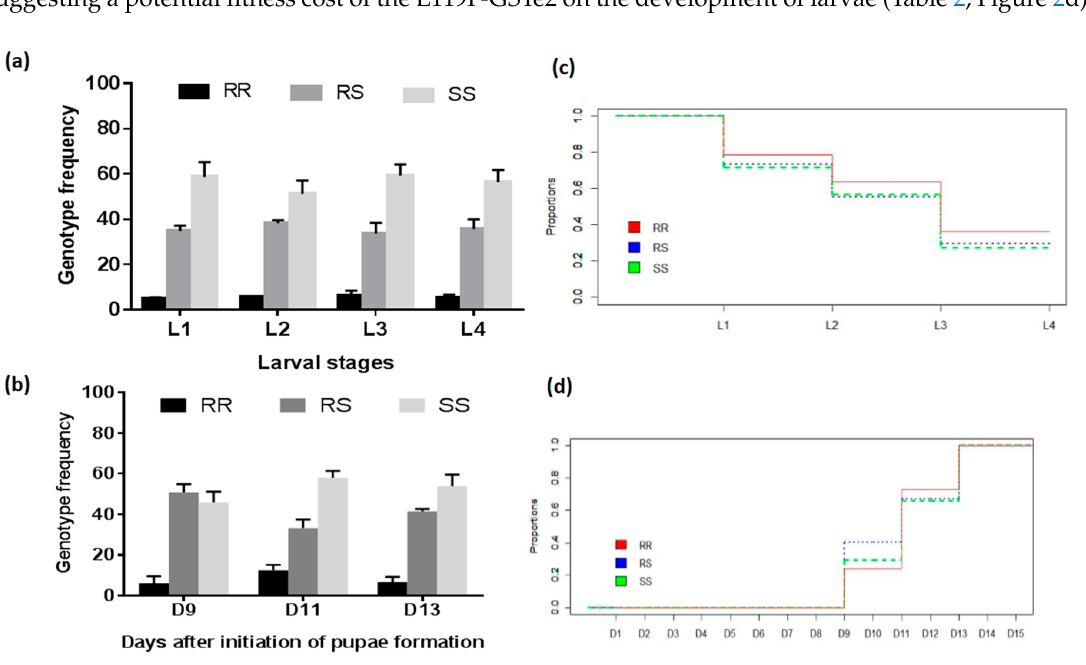
Figure 2. Distribution of the L119F-GSTe2 genotypes at different time-points of the development of immature stages. ( a ) Histogram of the variation in genotypes frequency during the development of larvae (L1, L2, L3, and L4 represent different larval stages) and pupae formation ( b ); ( c ) the proportion of larvae surviving at each developmental stage from hatching (D1) to formation of the pupae; ( d ) the proportion of pupae obtained in D9, D11 and D13 of development. Colored bars and lines indicate respectively 119F/F-RR, L119F-RS and L/L119-SS genotypes. Standard error ( n = 3) are also indicated for the histograms. Table 2. Association between L119F-GSTe2 genotypes and pupae formation. * significant difference